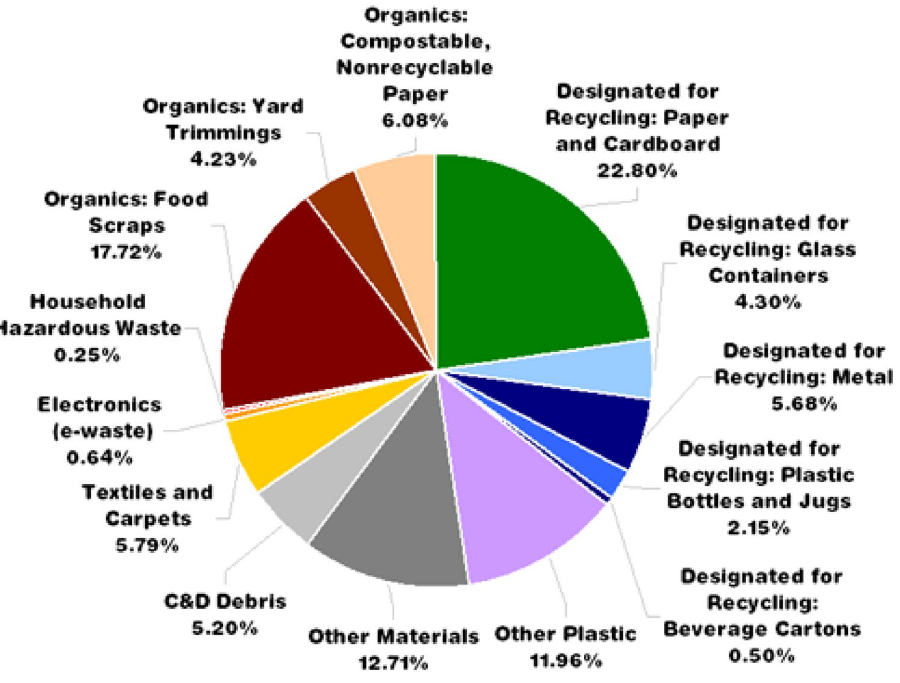
Figure 3. Recycling and utilization potential of solid